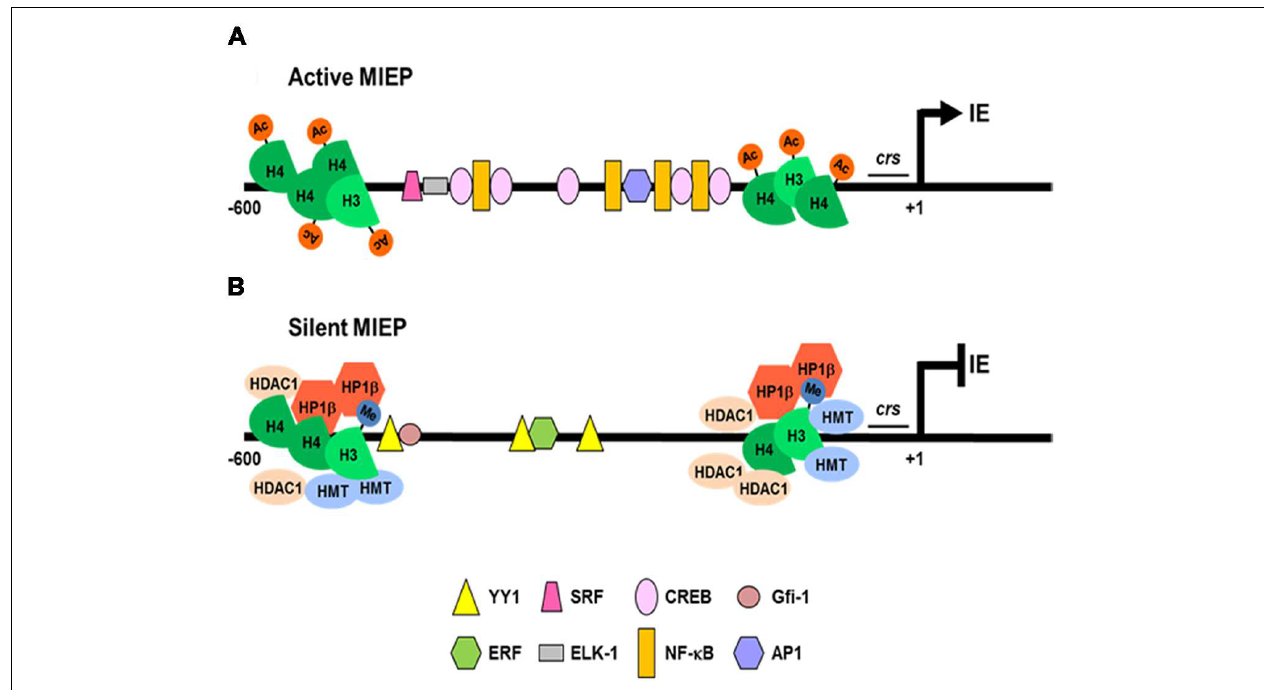
FIGURE 1 | Regulation of HCMV MIEP activity during lytic and latent infections. (A) In cells permissive to lytic infection, the MIEP is associated with acetylated histones (Ac; H4 and H3) and many constitutive and inducible cellular transcription factors (NF- κ B, CREB, AP1, SRF, and Elk-1) bind to cognate binding sites to activate IE genes transcription. (B) In latently infected cells, cellular transcriptional repressors (YY1, ERF, and Gfi-1) bind and recruit histone deacetylases (HDAC1) and methyltransferases (HMT) to the MIEP. The reduced content of acetylated H4 and the increase of dimethylated H3 histones (Me), promotes recruitment of the silencing protein (heterochromatin protein 1 -HP1 β -), thus determining repression of the MIEP transcriptional